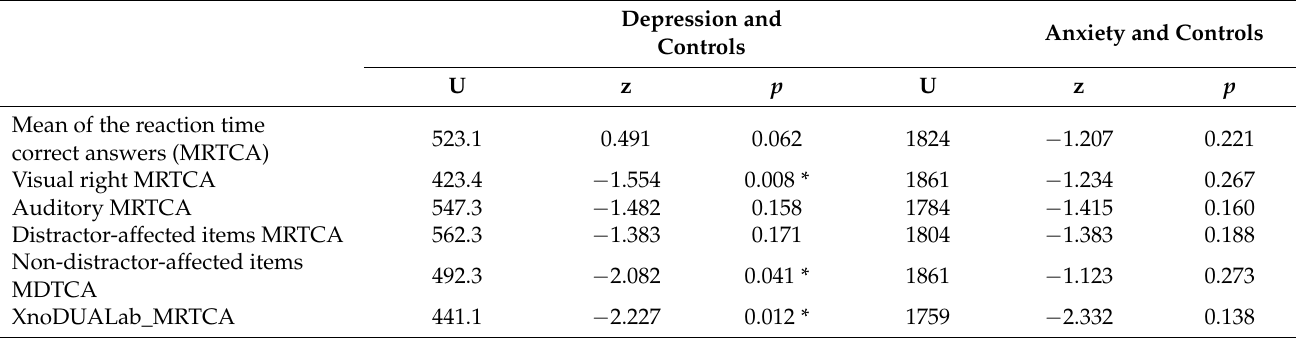
Table 2. Contrast of means between groups with depression and anxiety and controls. Processing speed. Depression and